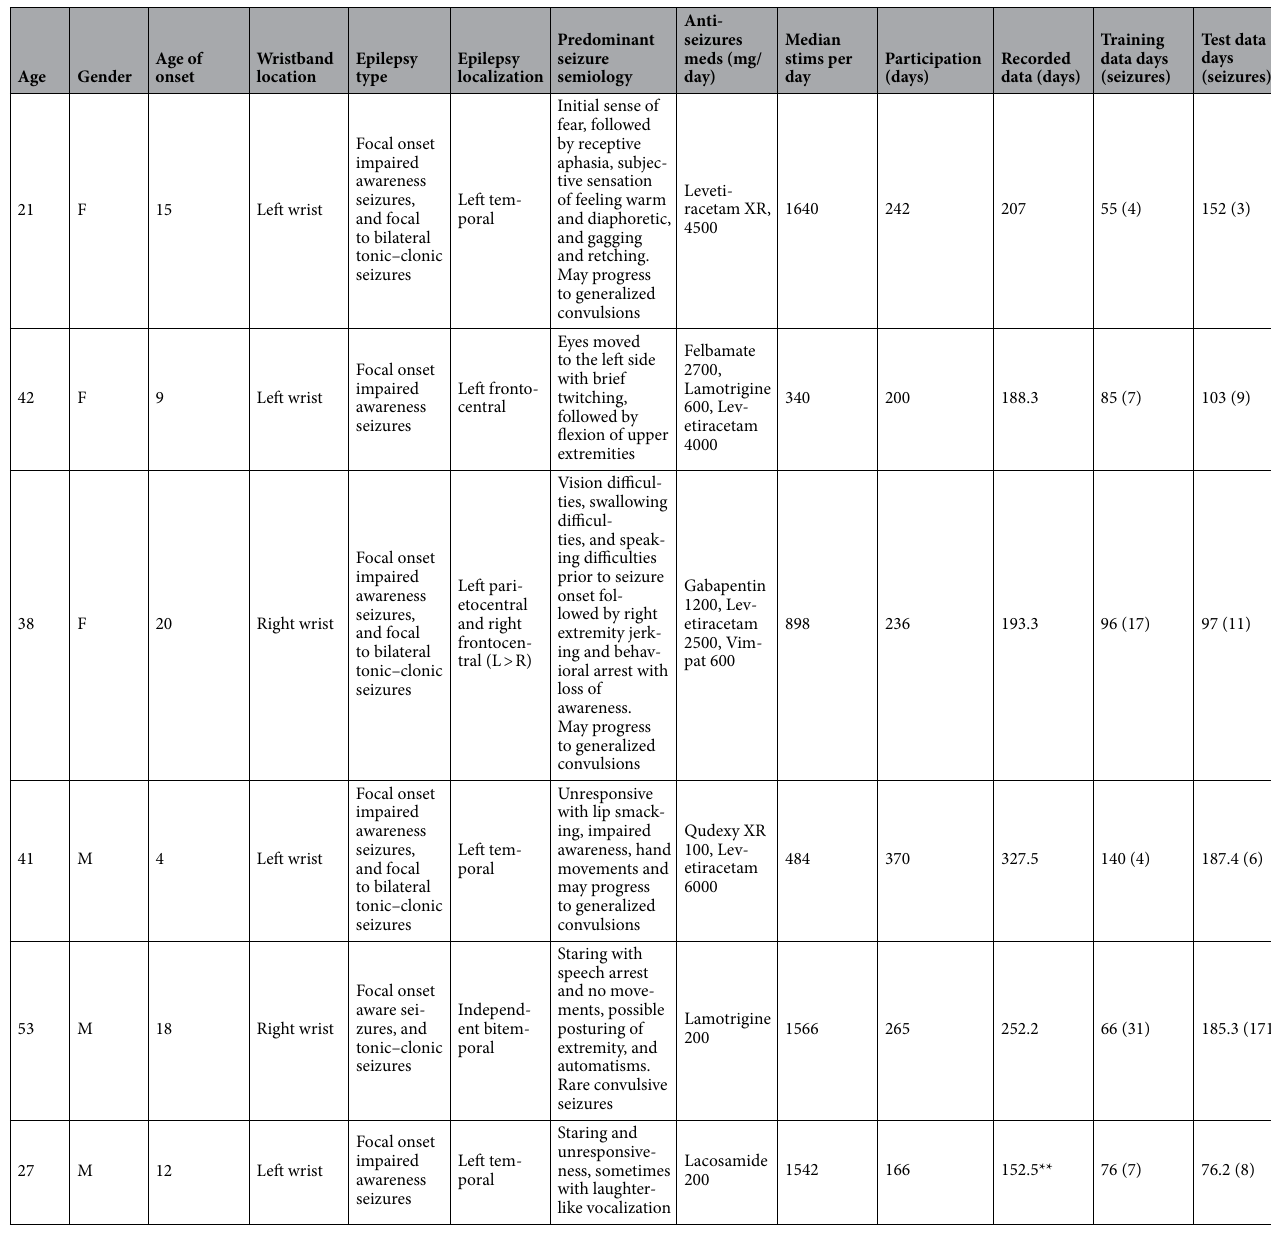
Table 1. Cohort demographics, epilepsy characteristics, and data characteristics. The median (range) age was 39.5 (21–53) years, and the cohort consisted of three males and three females. Lead seizures are reported and clustered (< 4 h separation) seizures were not included. **662 h of recording excluded due to bad BVP and HR